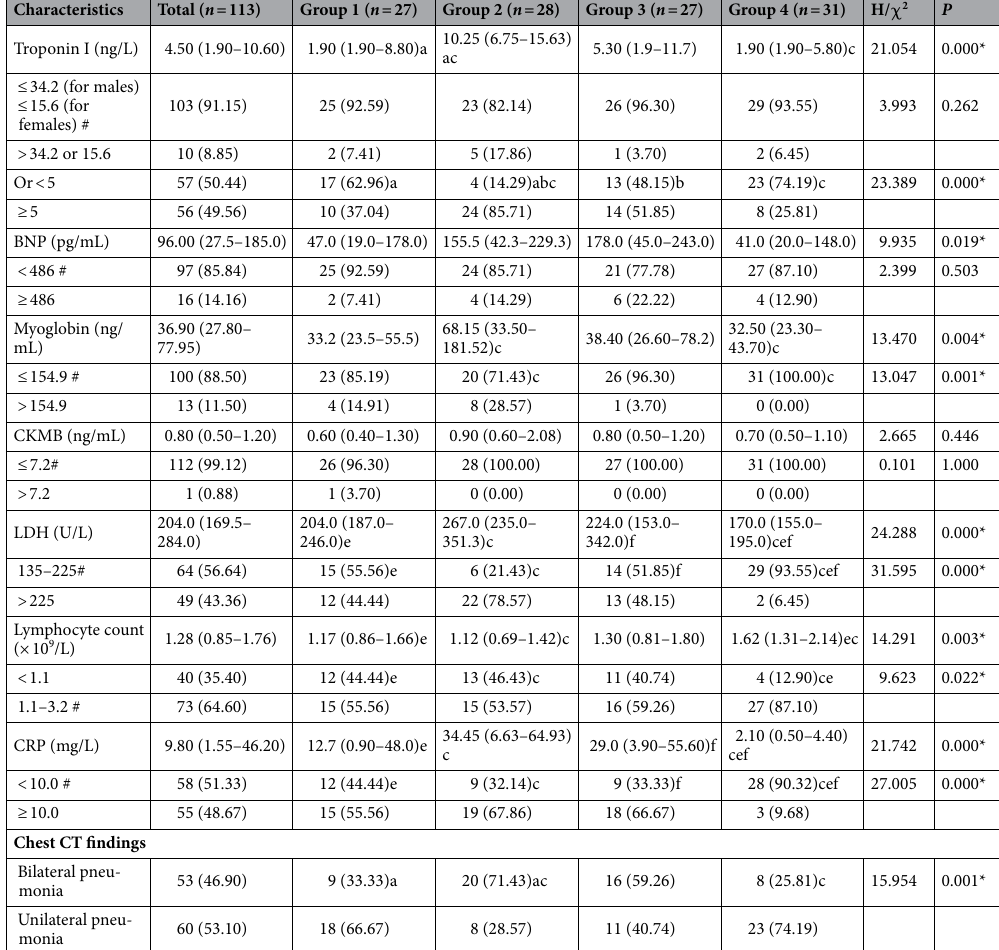
Table 2. Comparisons of cardiac biomarkers, CRP, lymphocyte count, and radiological findings across the four groups. Data are shown as median (interquartile range) or n (%). P values were calculated by Kruskal–Wallis test, χ 2 test or Fisher’s exact test, as appropriate. BNP, B-type natriuretic peptide; CKMB, creatine kinase-myocardial band; LDH, lactic dehydrogenase; CRP, C-reactive protein; * denoted P < 0.05; # denoted Reference intervals of analytes. a denoted P bonferroni < 0.05 between group 1 and group 2. b denoted P bonferroni < 0.05 between group 2 and group 3. c denoted P bonferroni < 0.05 between group 2 and group 4. d denoted P bonferroni < 0.05 between group 1 and group 3. e denoted P bonferroni < 0.05 between group 1 and group 4. f denoted P bonferroni < 0.05 between group 3 and group